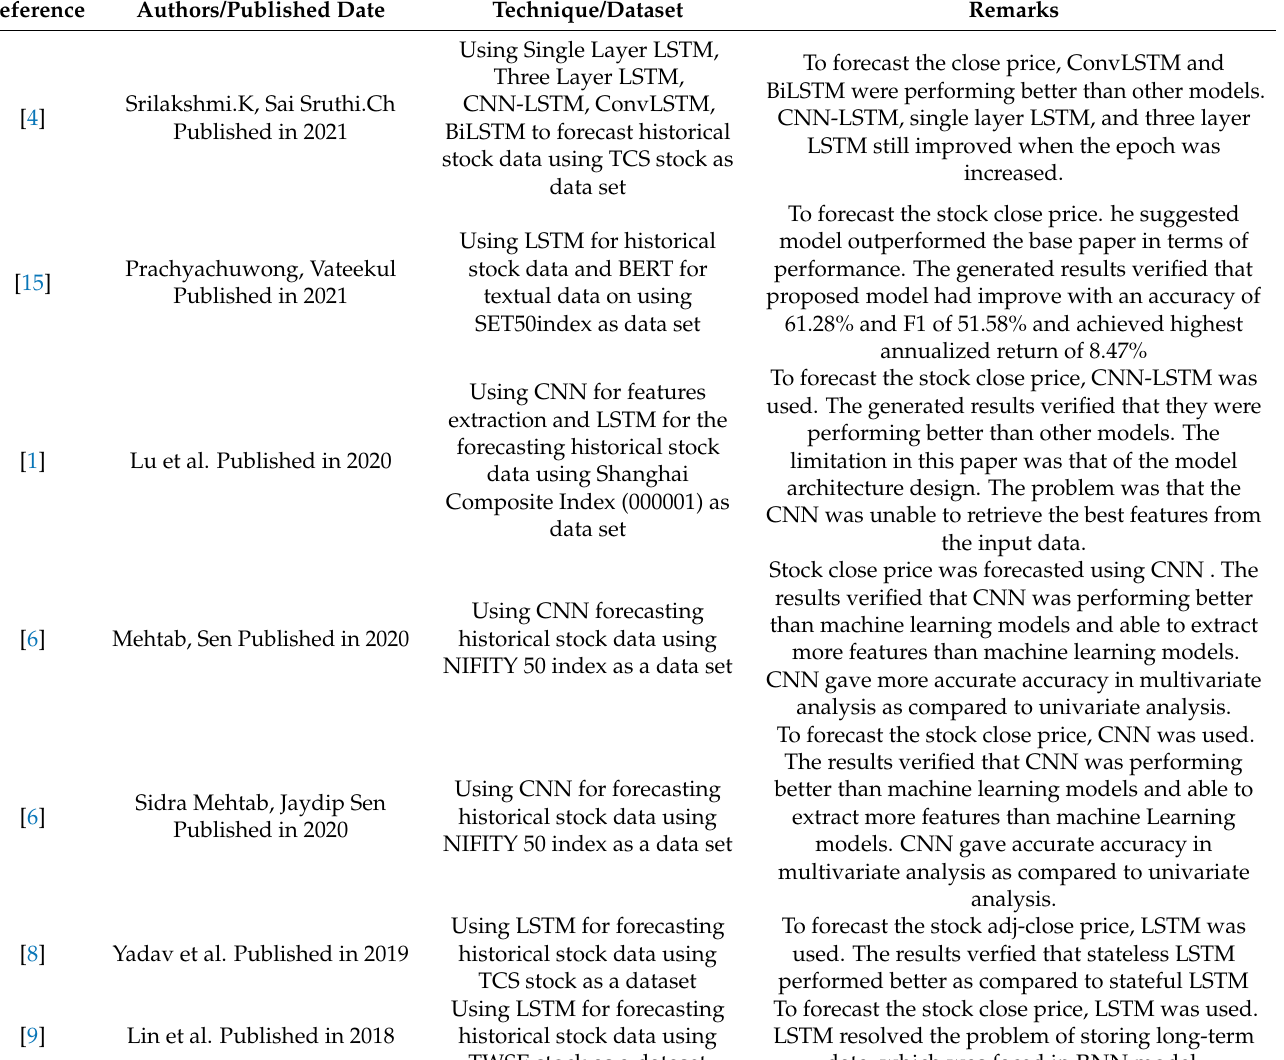
Table 1. Analysis of previous